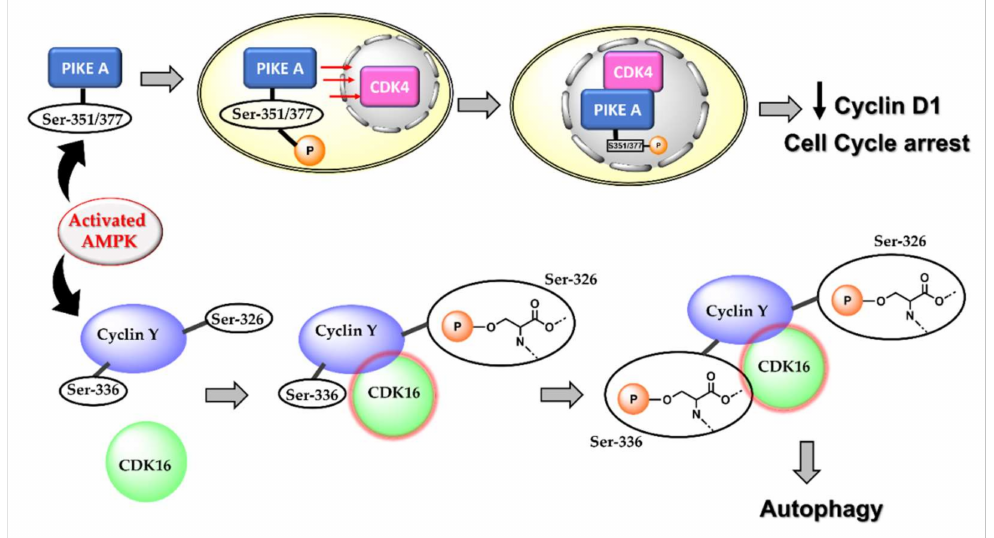
Figure 3. Known mechanisms of activated AMPK-mediated downregulation of cyclin D1, cell cycle arrest, and autophagy. AMPK phosphorylation activates various cyclin-dependent kinases (CDKs) to result in downregulation of cyclin D1 and cell cycle arrest in the G1/S phase as well autophagy, all of which have been implicated in anticancer